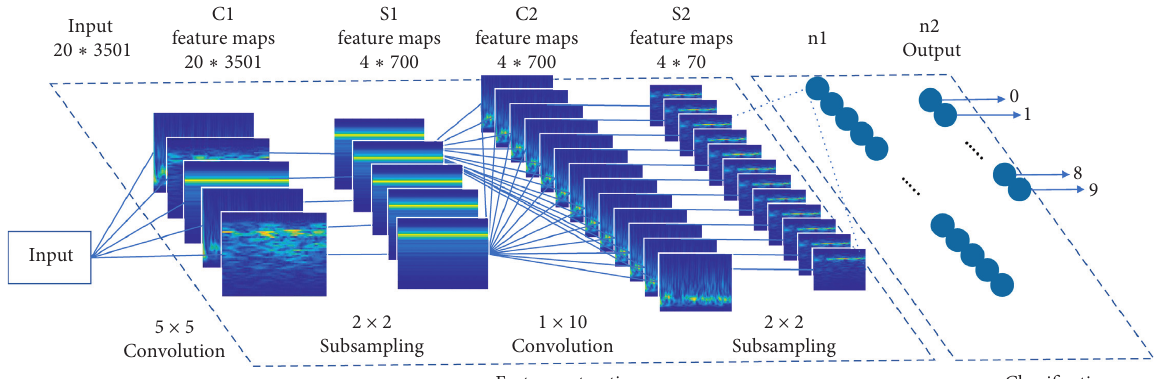
Figure 4: The four-layer convolution neural network classifier structure used in this